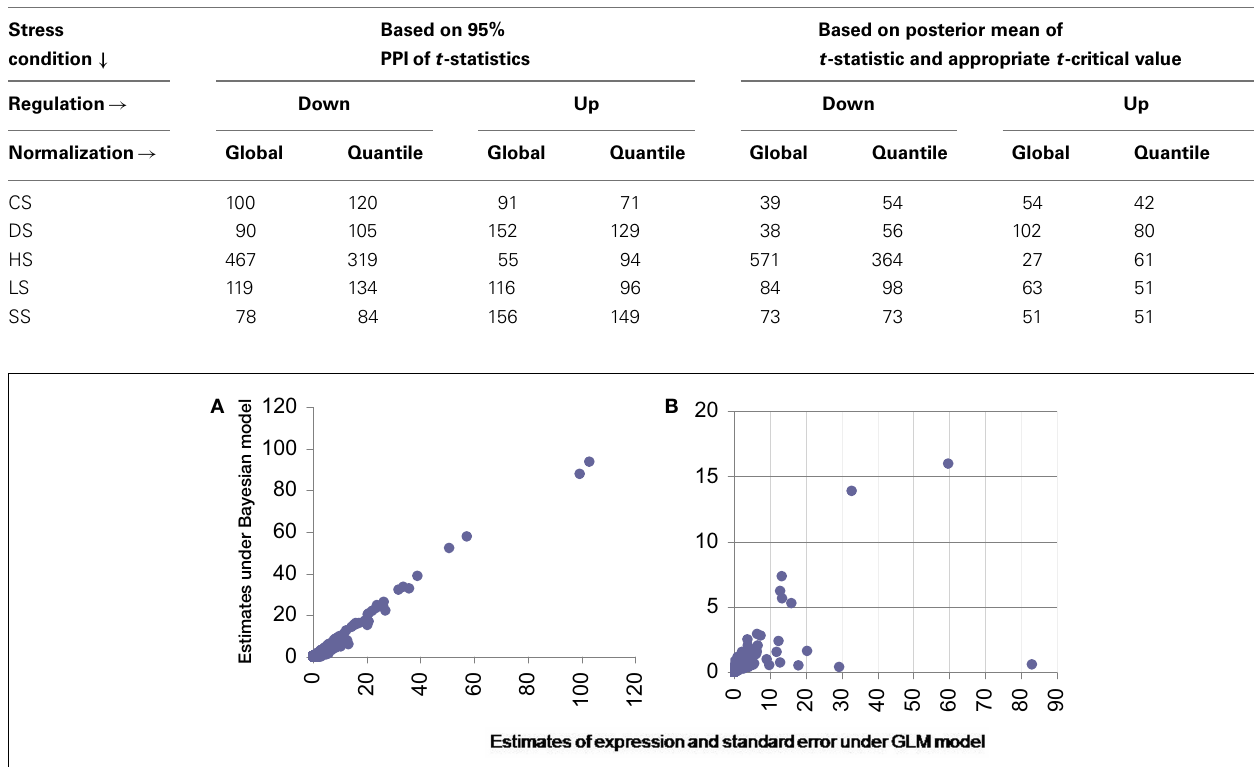
Table 2 | Up and down regulated isoforms for each stress conditions when compared withWT, using alternate definitions of differential expression.